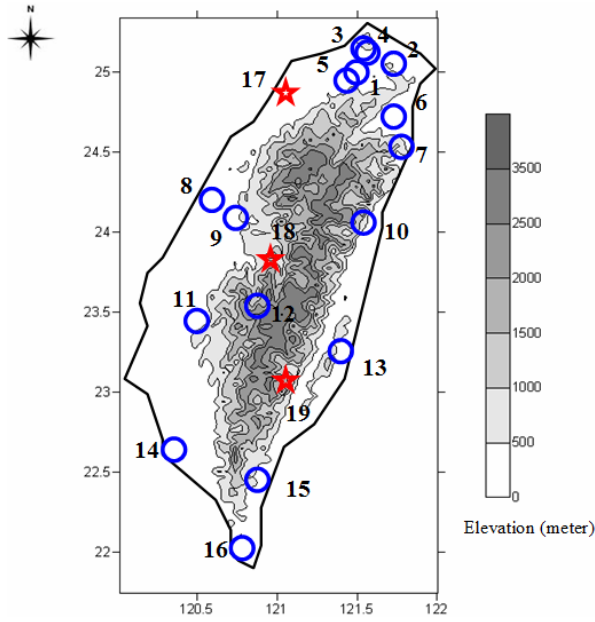
Fig. 3. Location of meteorological stations in Taiwan.